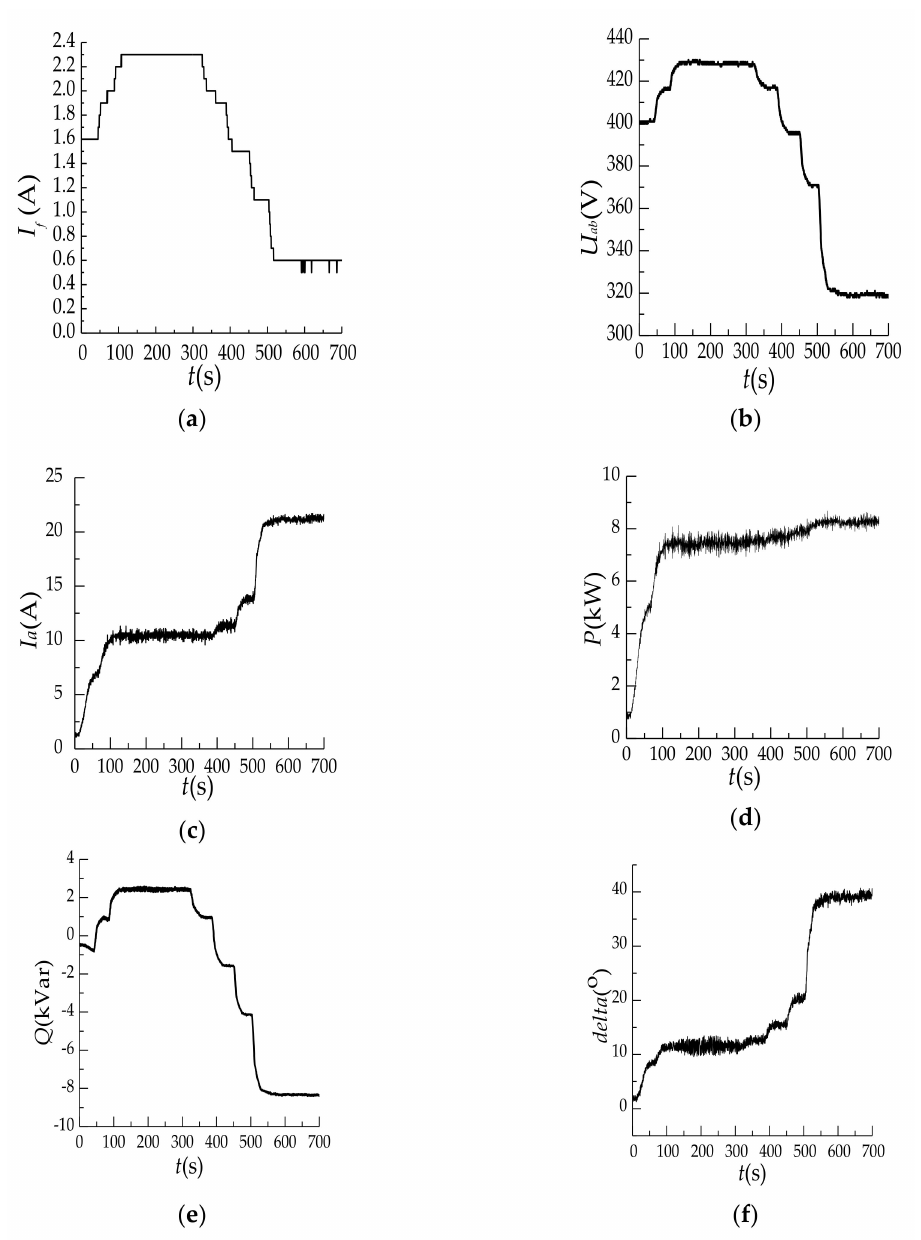
Figure 10. Electrical-parameter variation curves: ( a ) Excitation current; ( b ) Terminal voltage; ( c ) Stator winding current; ( d ) Active power; ( e ) Reactive power; ( f ) Power